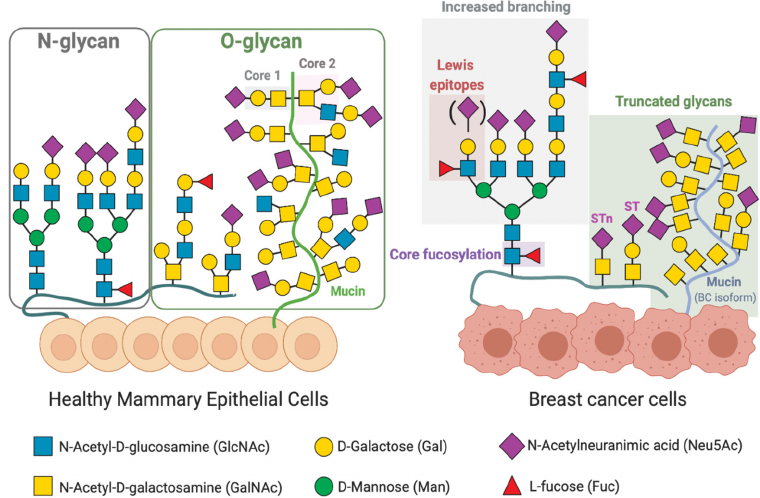
Figure 2. Altered glycosylation patterns of surface glycoproteins on breast cancer cells. Healthy mammary epithelial cells present at their surface diverse glycans, which are attached by a N-Acetylglucosamine (GlcNAc) to an asparagine (Asn) site—N-glycans—or by a N-Acetylgalactosamine (GalNAc) to a serine/threonine site (Ser/Thr; mucin-type O-glycans). Upon tumorigenesis, BC cells acquire a deregulated synthesis of glycans, which influences interactions between tumour cells and the surrounding microenvironment. Altered glycosylation in BC is characterized by an increase in Lewis antigens (Lewis a and Lewis x ; the sialylated Lewis x and Lewis a ) and an increase in α 1-6-core fucosylation and branching of N-glycans. Additionally, truncated O-glycans are highly expressed in BC usually with terminal sialic acid. Monosaccharides are represented according to the symbol nomenclature for glycans (SNFG) [8,37,39,41].